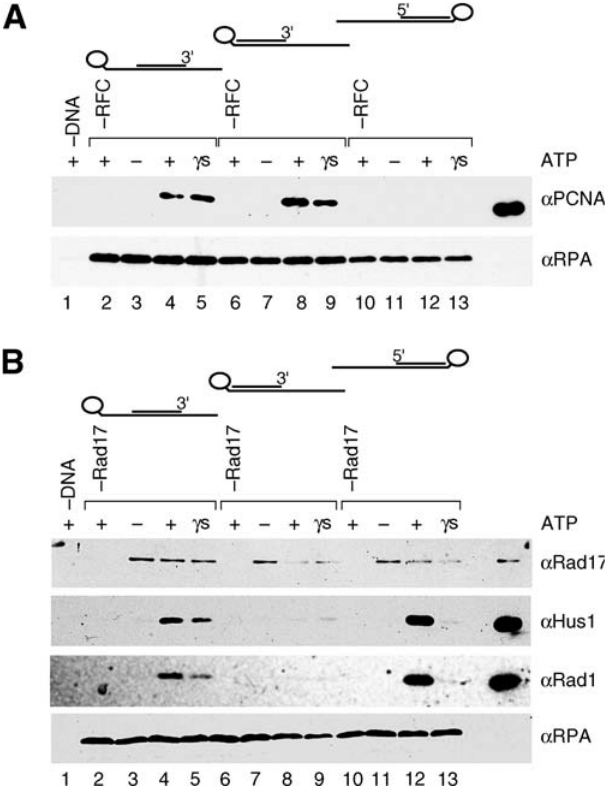
Figure 4. Opposite DNA Substrate Preference Exhibited by RFC and RSR Loading reactions in (A) and (B) were performed as described in the Materials and Methods with DNA substrates bound to beads, and recovery of proteins with the beads was analyzed by Wb for the indicated proteins. Lanes represent reactions using either a 5 9 and 3 9 recessed primer–template DNA (lanes 2–5), a 3 9 recessed primer– template DNA (lanes 6–9), a 5 9 recessed primer–template DNA (lanes 10–13), or no DNA (lane 1). All reactions contained RPA and the indicated nucleotide (ATP: lanes 1, 2, 4, 6, 8, 10, and 12; ATP c S: lanes 5, 9, and 13) or no nucleotide (lanes 3, 7, and 11). In (A), all reactions contained 0.25 pmol of RFC (except for those in lanes 2, 6, and 10) and 2 pmol of PCNA. In (B), all reactions contained 0.25 pmol of RSR (except for those in lanes 2, 6, and 10) and 1 pmol of RHR. In both (A) and (B), 20% of the input in each reaction is represented in the last lane in each